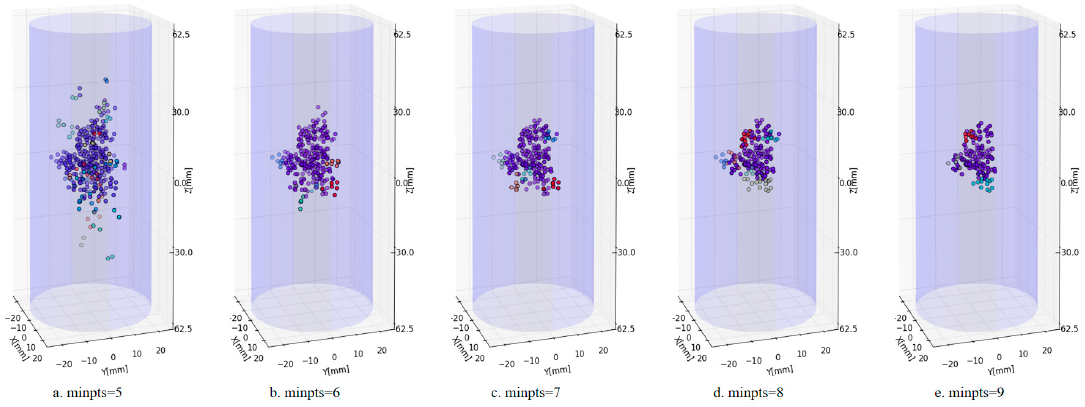
Figure 14. Calculated clusters using different MinPts values and fixed Eps_s (5 mm), Eps_t (200 ms).